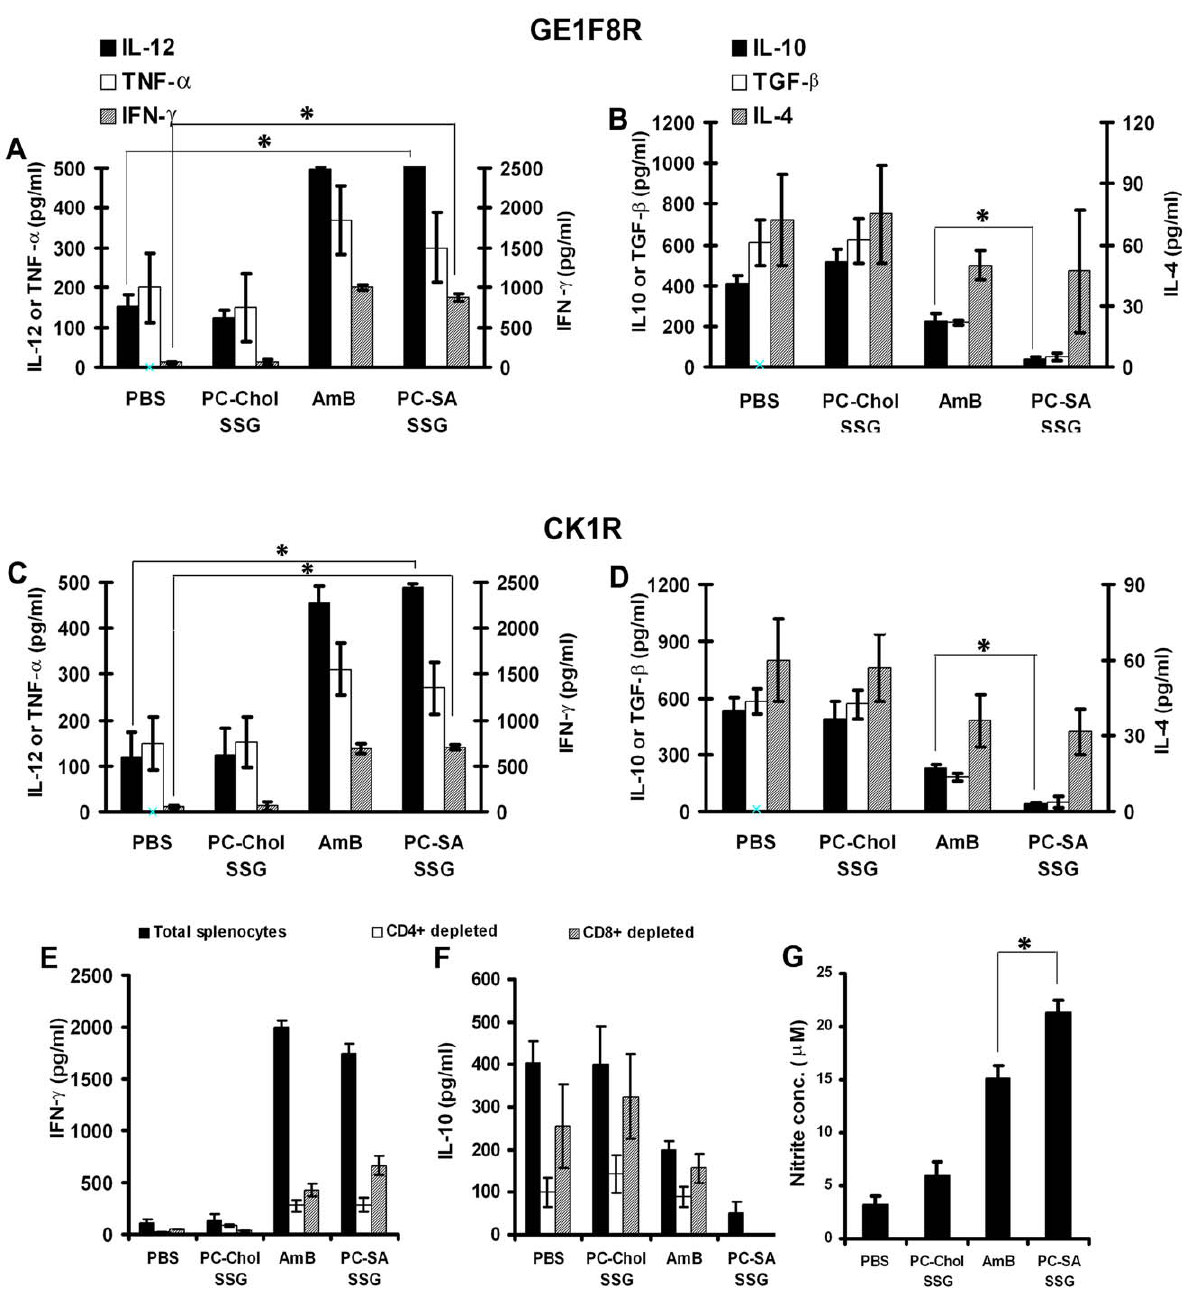
Figure 7. Differential pattern of cytokine and NO production following therapy with antileishmanial formulations in infected BALB/ c mice. Splenocytes isolated from GE1F8R and CK1R-infected mice after indicated treatments were plated aseptically, and stimulated with LAg (12.5 m g/ml) for 72 h. (A, C) IFN- c , IL-12, TNF- a and (B, D) IL-10, TGF- b , IL-4 cytokine levels in supernatants of splenocyte cultures were assayed by ELISA. Total, and CD4 + and CD8 + T cell-depleted splenocytes were stimulated as above and (E) IFN- c and (F) IL-10 levels were measured after 72 h. Values represent the mean 6 SEM (3–5 mice/group). (G) Leishmanicidal NO generation determined by Greiss assay method in supernatants of splenocytes derived from indicated groups. Data represent the mean 6 SEM (3–5 mice/group). * p , 0.05 compared to (A, C) PBS or (B, D,G) AmB therapy.